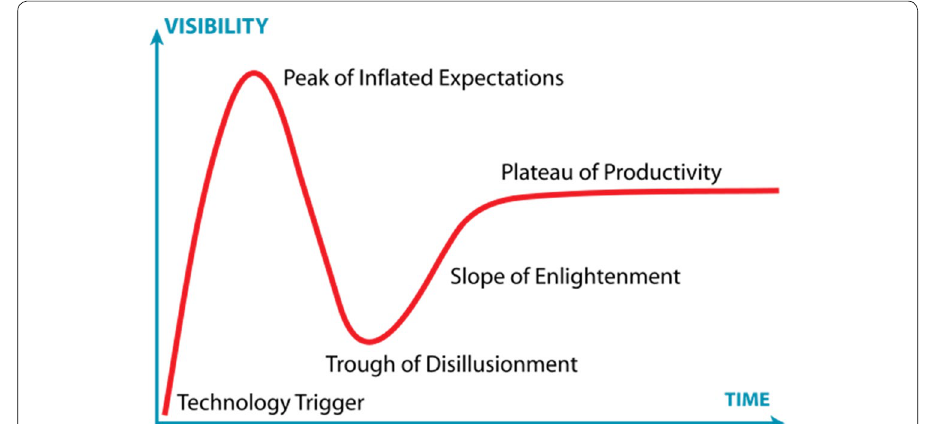
Fig. 1 The Gartner hype cycle (Created by Jeremy Kemp, downloaded from [21], reused under the GNU